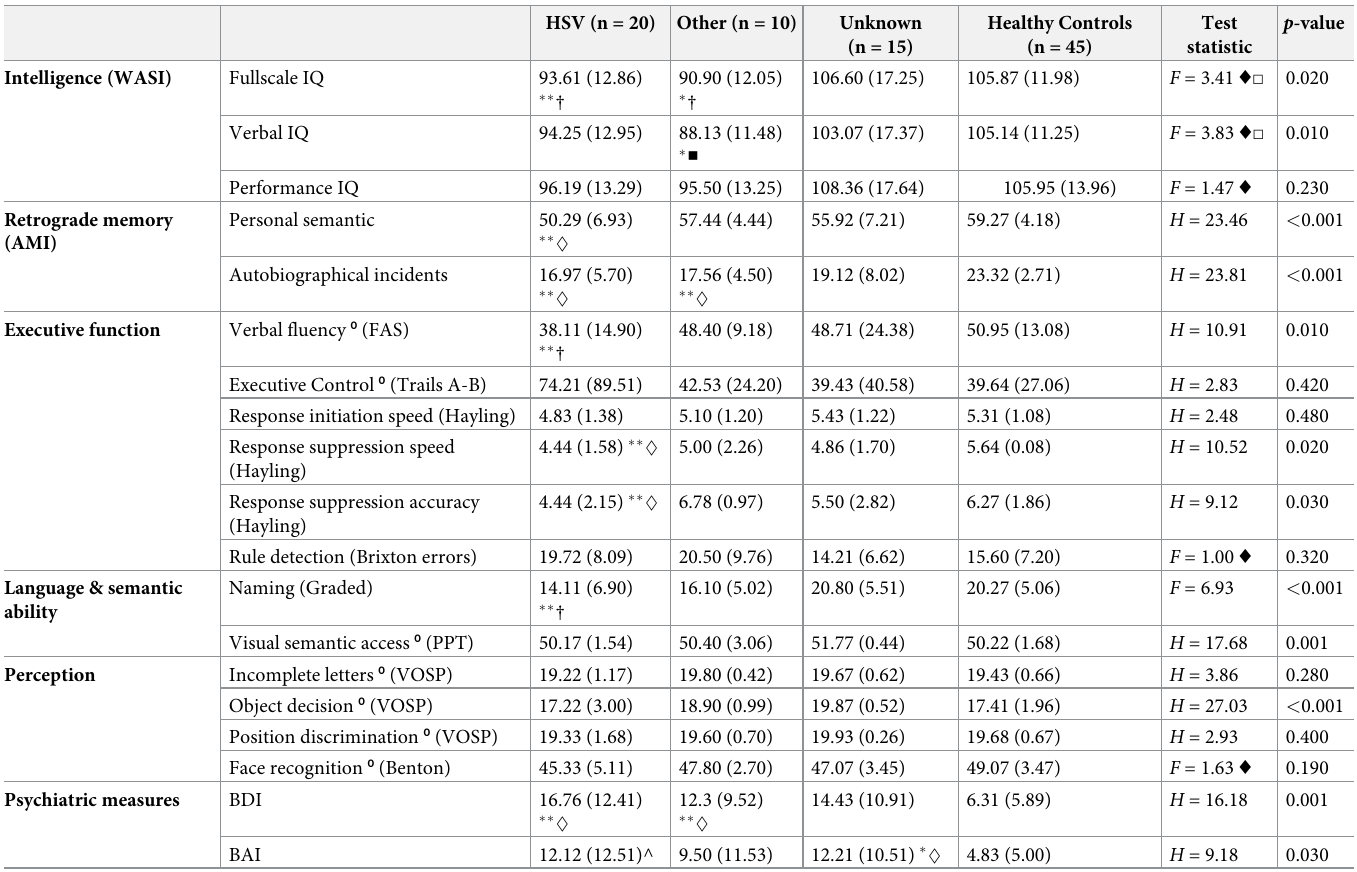
Table 2. Short-term neuropsychological and psychiatric assessment scores in the short- and medium-term outcome